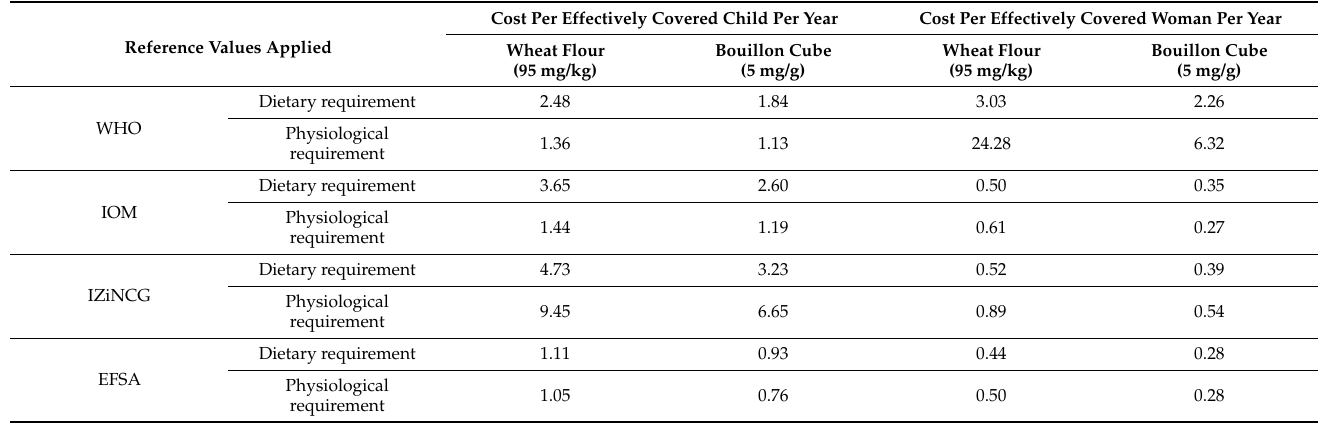
Table 3. Cost-effectiveness of 10-year zinc fortification programs in addressing the prevalence of inadequate zinc intake in Cameroon: estimated based on WHO, IOM, IZINCG, and EFSA dietary requirements and physiological requirements. The cost is in US$.